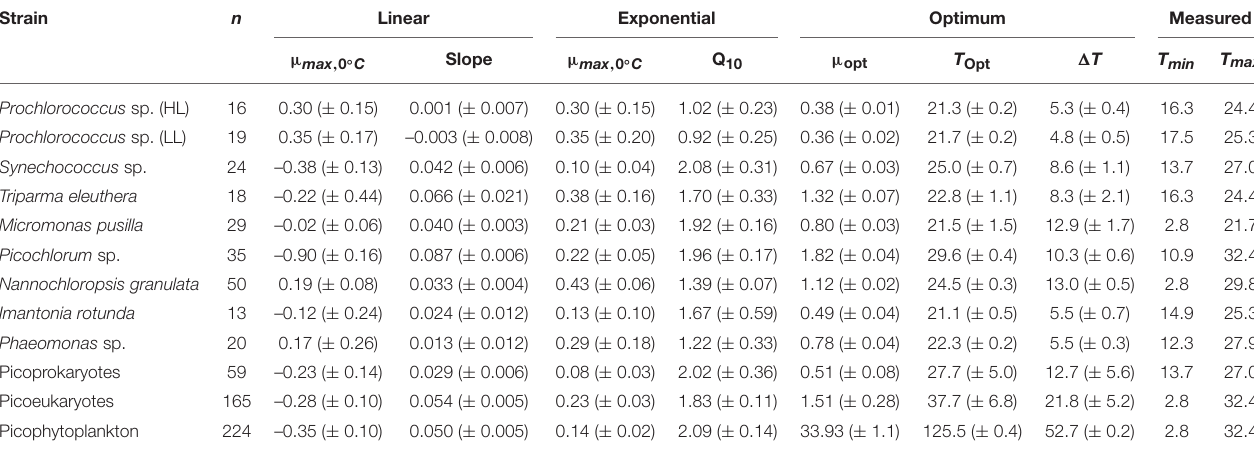
TABLE 3 | Temperature-related parameters for a linear, exponential, and optimum fit to represent the response of the maximum growth rates to temperature for individual picophytoplankton strains, both groups of picoprokaryotes and picoeukaryotes, and picophytoplankton. Strain n